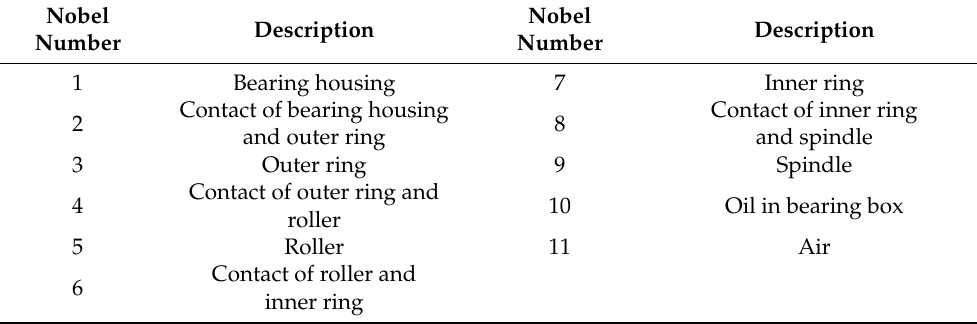
Figure 4. Node division of the rolling bearing system. Table 1. The description of